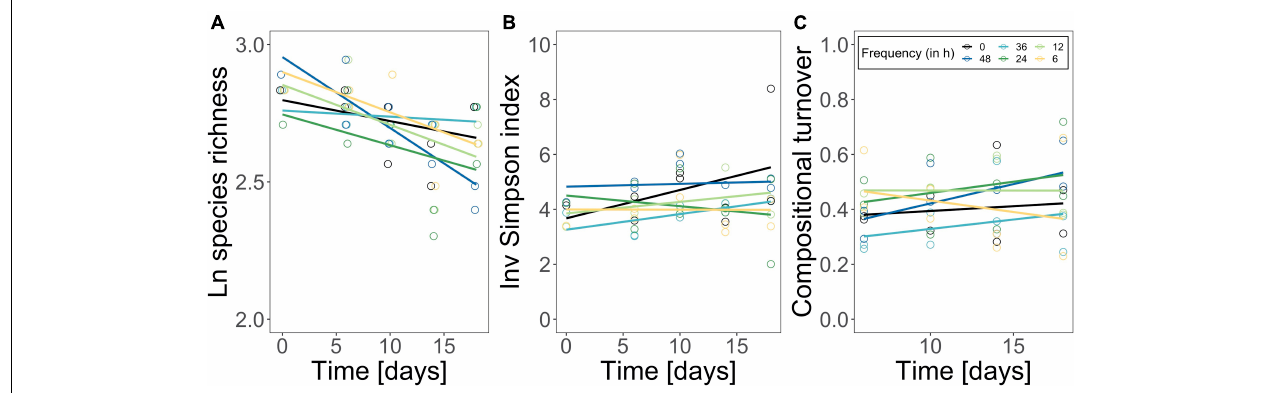
FIGURE 3 | Logarithmized species richness (A) , inverse Simpson diversity index (B) and compositional turnover (Bray-Curtis distance of phytoplankton community) (C) over time. The constant treatment is in black, fluctuation treatments are highlighted following a color gradient (dark blue fluctuation every 48 h—yellow fluctuation every 6 h). Each point represents one replicate ( n = 2). Lines represent linear loess-fits added to visualize the trend over